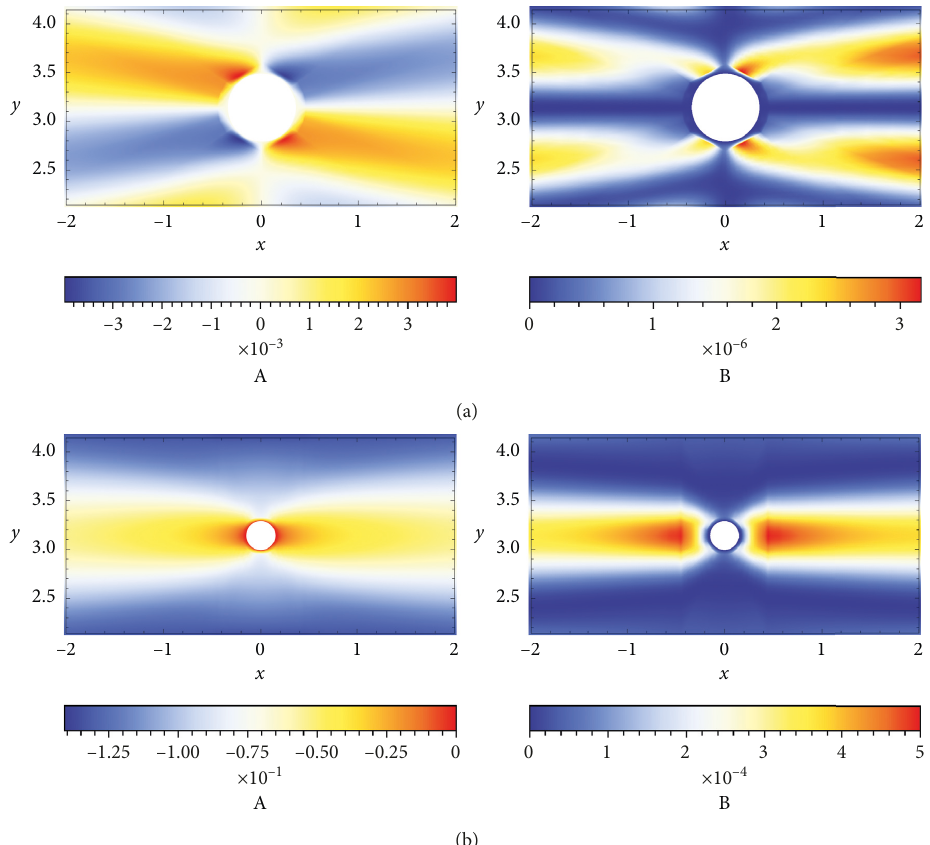
Figure 8: Statistics of the fifth field component ψ near the T-junction. (a) Long cylinder: expected value (A) and variance (B). (b) Short cylinder: expected value (A) and variance